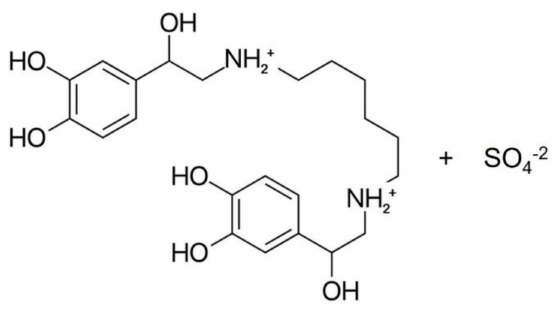
Figure 2. Molecular structure of hexoprenaline sulphate.